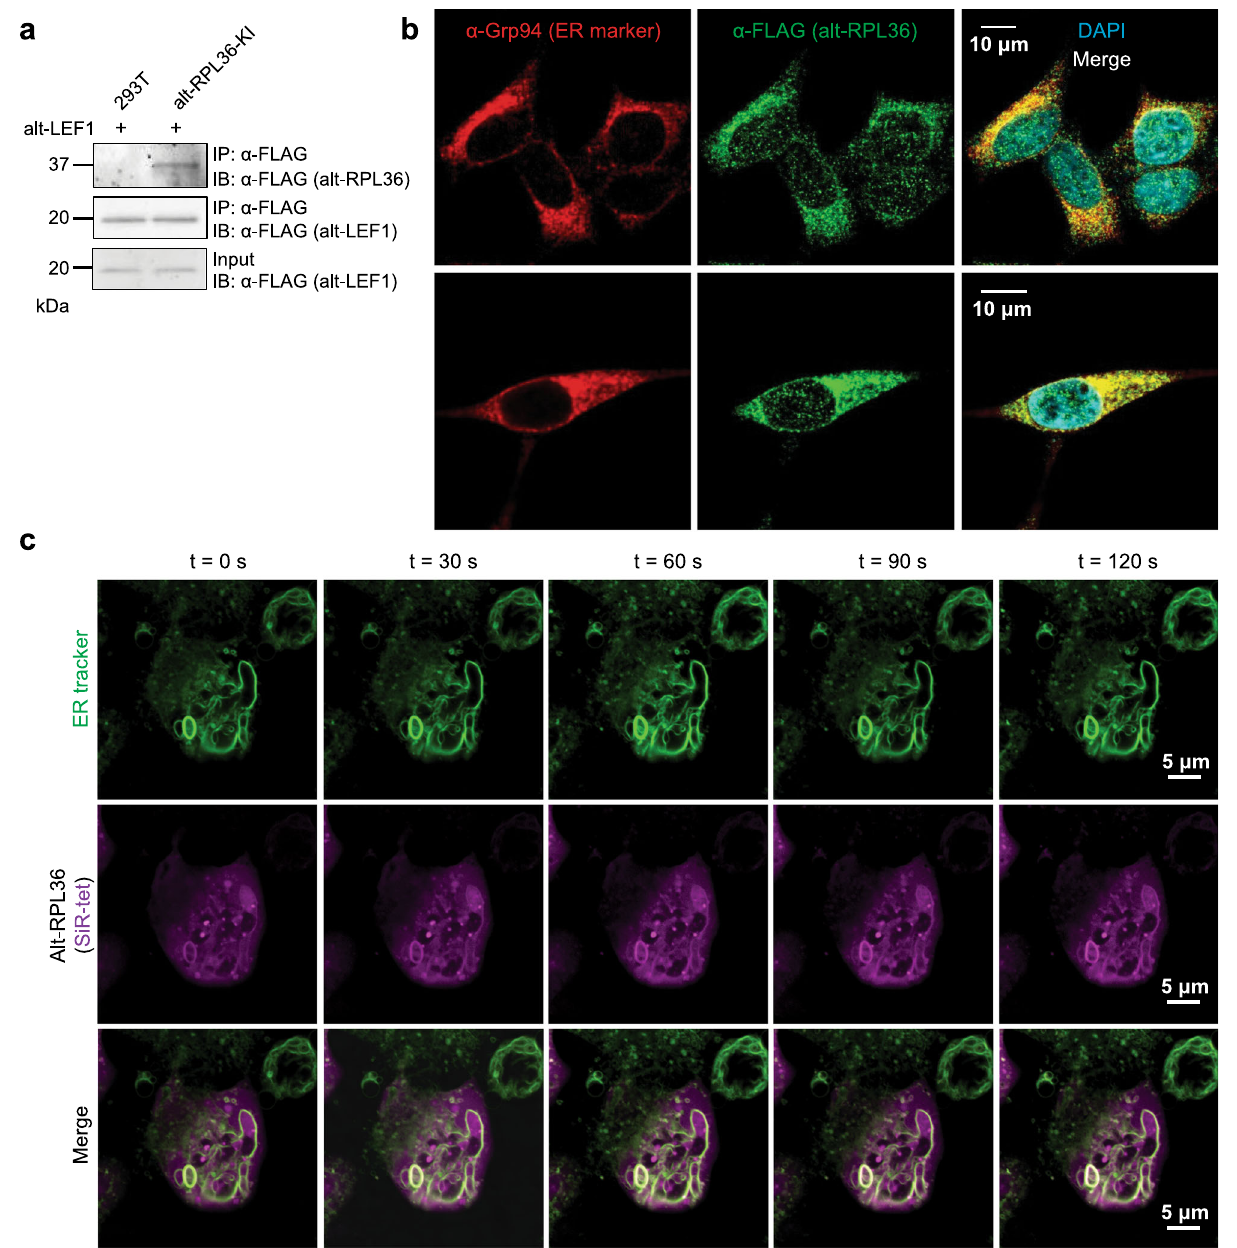
Fig. 2 Alt-RPL36 is endogenously expressed and partially localizes to the endoplasmic reticulum. a Control HEK 293T cells (lane 1) or alt-RPL36-GFP11- FLAG knock-in (KI) HEK 293T cells (lane 2) were transfected with alt-LEF1-FLAG (which is a recently identi fi ed ~20 kDa alt-ORF[1]), serving as a FLAG-IP control, and IPs were performed with anti-FLAG antibody followed by IB with anti-FLAG. Cell lysates (1%) before IP (input) were used as the loading controls. Data are representative of three biological replicates. b Confocal imaging of alt-RPL36-GFP11-FLAG KI cells after immunostaining with anti-Grp94 (red), anti-FLAG (green), and DAPI (cyan). Scale bar, 10 µ m. Data are representative of three biological replicates. c Live-cell imaging of alt-RPL36 via genetic code expansion. HEK 293T cells were transfected with plasmids expressing M. mazei pyrrolysyl-tRNA synthetase bearing Y306A/Y384F mutations (PylRS-AF), amber-suppressing Pyl tRNA (PylT CUA ), and alt-RPL36 L18TAG . Cells were incubated with 60 μ M bicyclononyne-lysine (BCNK) for 45 h, then labeled with tetrazine-silicon rhodamine (SiR-tet, magenta) and a live-cell ER tracker DPX dye (green) for 30 min before live-cell imaging. Time-lapse imaging over 2 min was shown. Scale bar, 5 µ m. Data are representative of three biological